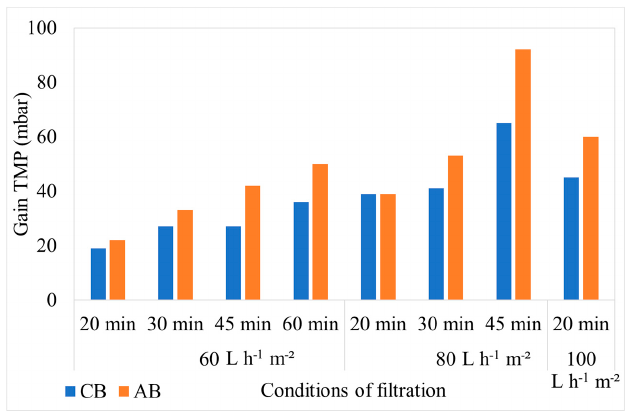
Figure 4. Gain of Transmembrane Pressure TPM after Classical Backwash (CB) and Air Backwash (AB)—filtration of natural seawater.